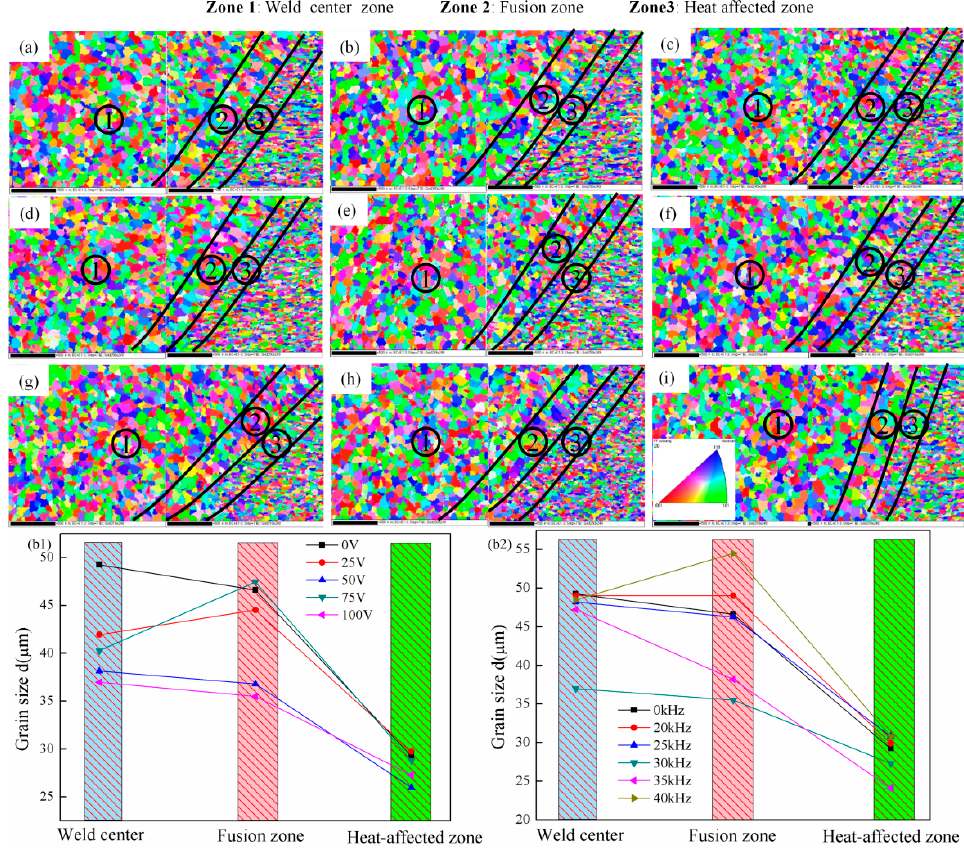
Figure 6 . Grain orientation at different ultrasonic excitation parameters from ( a ) 0 V, 0 kHz, ( b ) 25 V, 30 kHz, ( c ) 50 V, 30 kHz, ( d ) 75 V, 30 kHz, ( e ) 100 V, 30 kHz, ( f ) 100 V, 20 kHz, ( g ) 100 V, 25 kHz, ( h ) 100 V, 35 kHz, ( i ) 100 V, 40 kHz; and Grain size from different: ( b1 ) ultrasonic excitation voltages, and ( b2 ) ultrasonic excitation frequency.